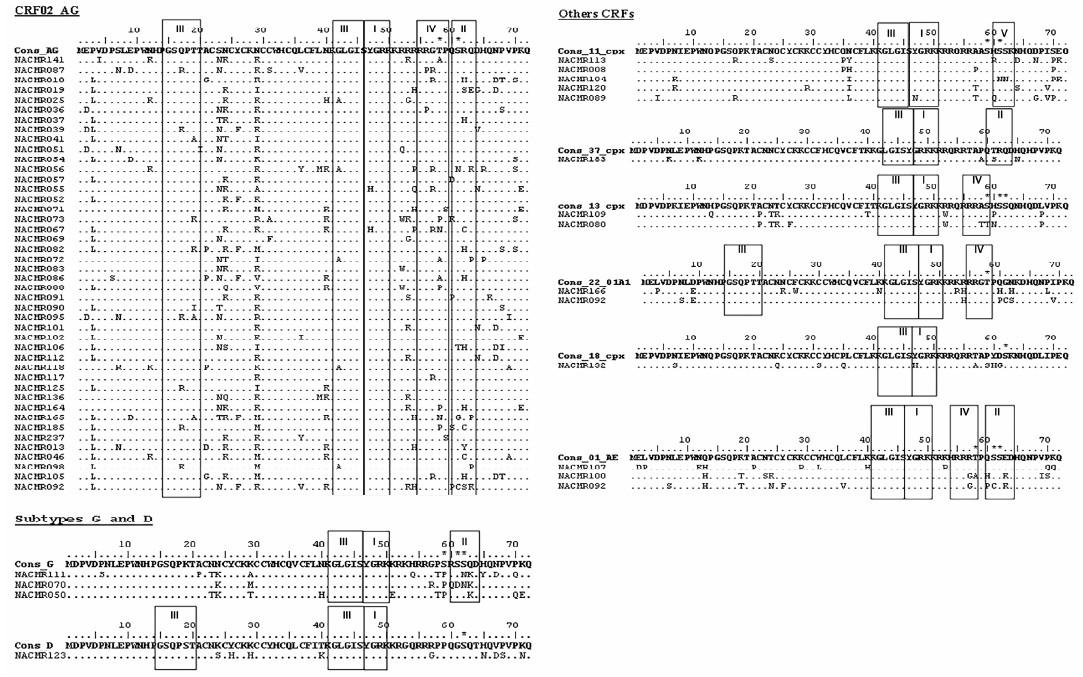
Figure 4. Motifs and post-translational modification (PTM) sites in Tat exon-1 of Cameroon clinical HIV-1 isolates. The Motif scan and Netphos.2.0 software were used to predict motifs and PTM sites in Cameroon Tat aa sequences as described Methods. For each subtype (CRF02_AG, G, D, CRF11_cpx, CRF37_cpx, CRF13_cpx, CRF22_01A1, CRF18_cpx, and CRF01_AE), consensus sequences are shown, as well as the IDs of Cameroon samples. Data show the presence of amidation ( I ); casein kinase-II ( II ); N -myristoylation ( III ); cAMP protein kinase ( IV ); and protein kinase-C ( V ) sites; as well as the predicted phosphorylation sites and phosphorylated aa residues (asterisk). Dots indicate conserved aa compared